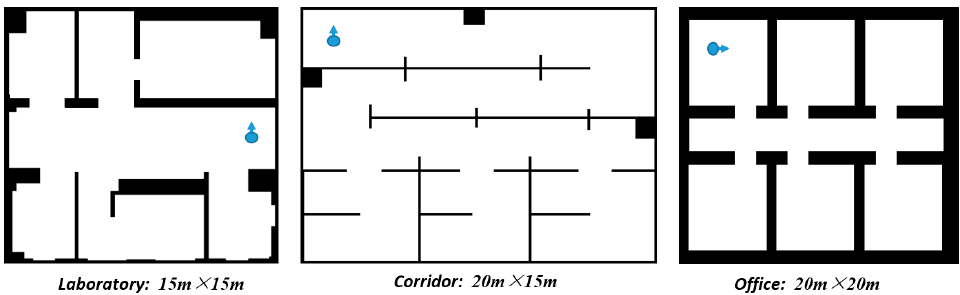
Figure 6. Different experimental environments with the initial pose of the robot.